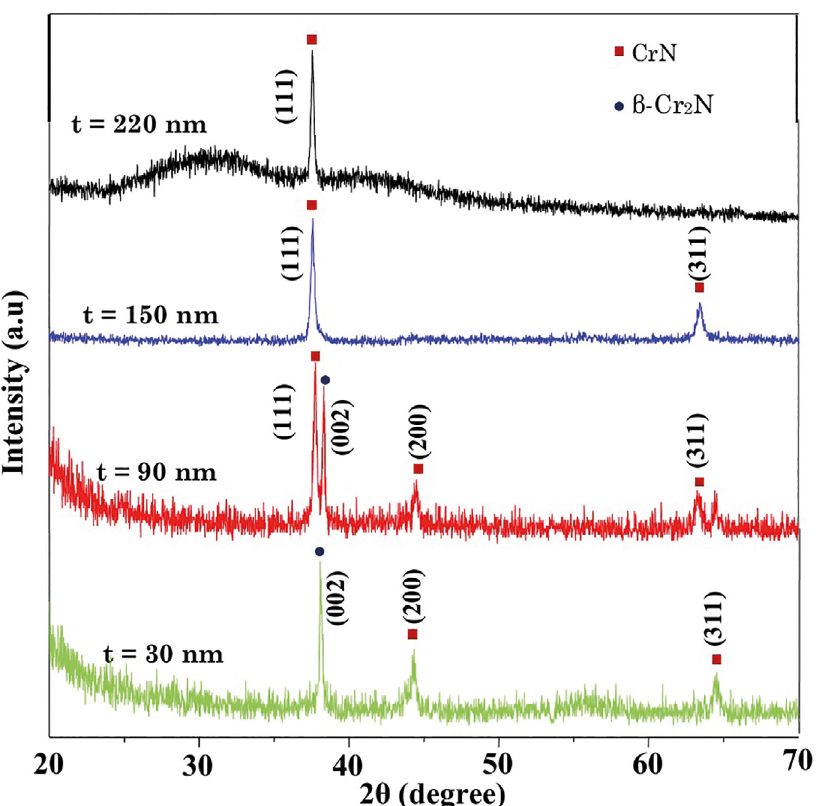
Figure 1. XRD pattern of different thicknesses of CrN/Si (100)